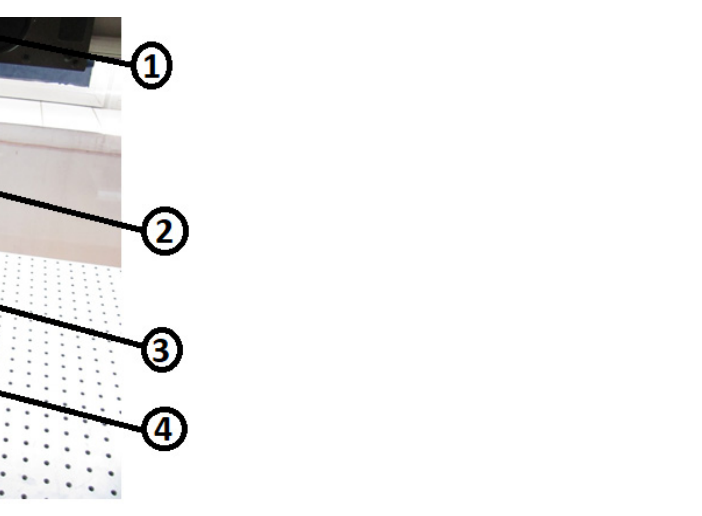
Figure 7. Adjustable system for MMI4D positioning. Legend: 1—reference for adjusting the position of the MMI4D on the Z axis; 2—cylinders for supporting MMI4D; 3—reference for fixing the MMI4D